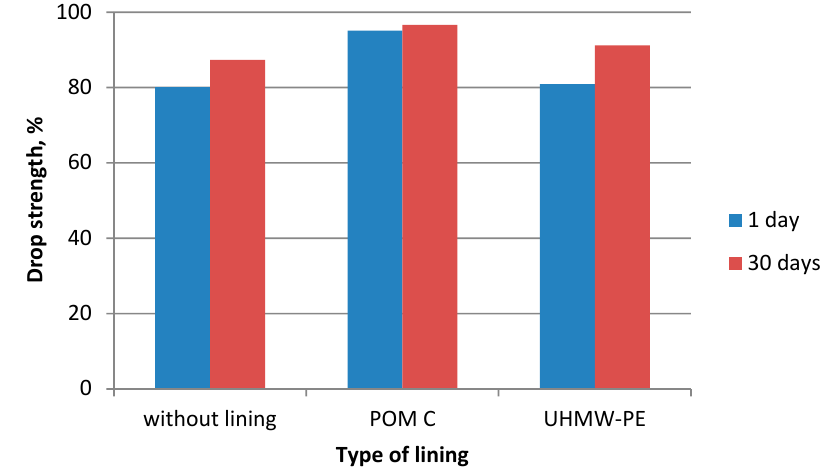
Figure 11. Compressive strength of briquettes made of Mixture 3 (charcoal fines mixed with 4% of starch).